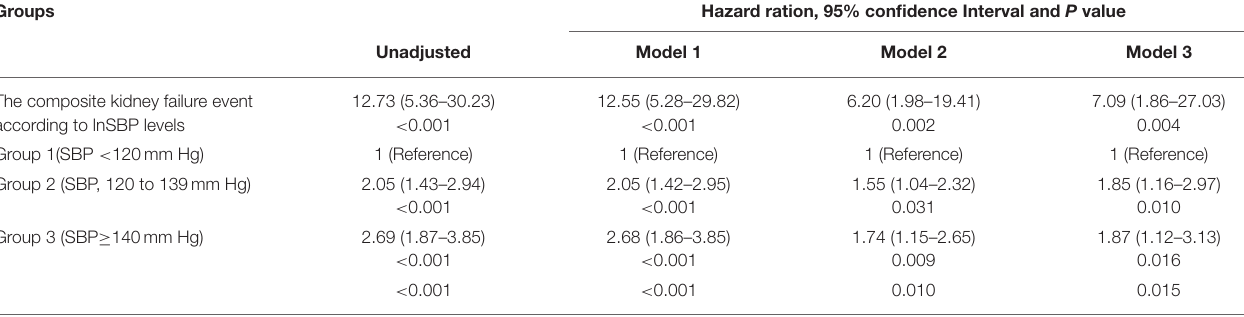
TABLE 2 | Risks of systolic blood pressure (SBP) in composite kidney disease progression in IgA nephropathy (IgAN). Groups Hazard ration, 95% confidence Interval and P